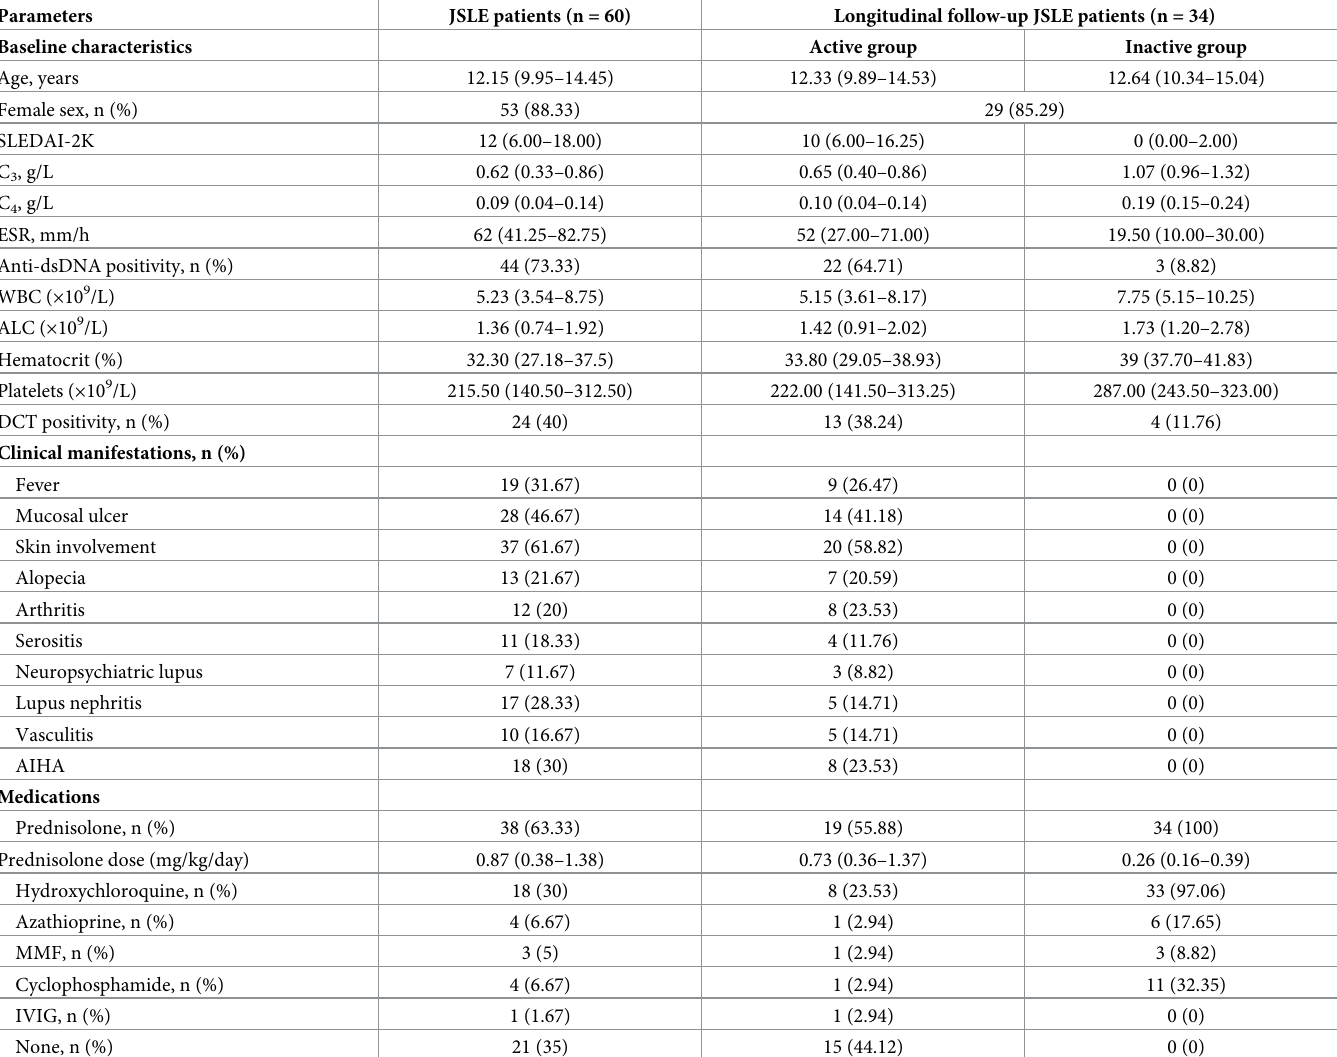
Table 1. Demographic, clinical, and laboratory parameters of the juvenile-onset systemic lupus erythematosus patients.